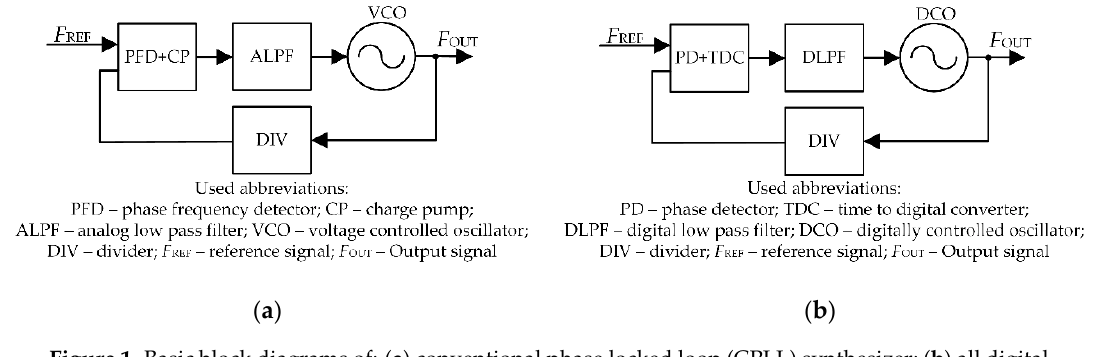
Figure 1. Basic block diagrams of: ( a ) conventional phase locked loop (CPLL) synthesizer; ( b ) all digital phase locked loop (ADPLL) synthesizer.